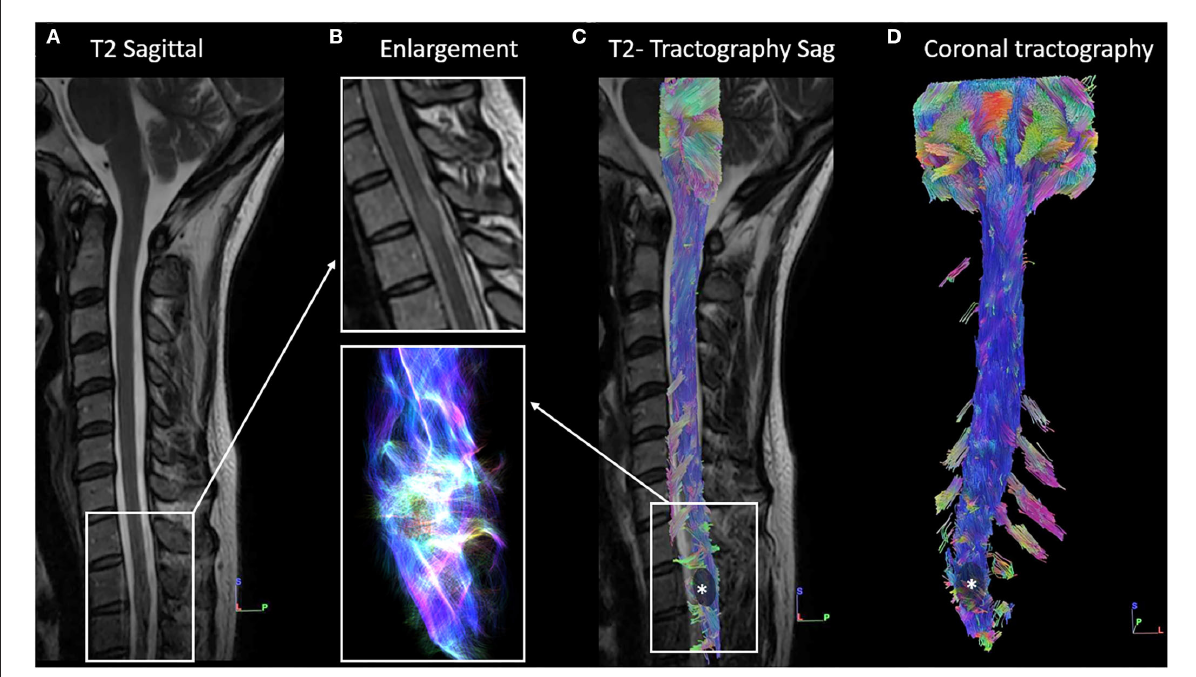
FIGURE6 Full cervical cord tractography in a patient with intramedullary tumor. (A) Sagittal T2-weighed image showing intramedullary isosignal at the Th2-Th3 spine level, associated with an increase in the volume of the spinal cord. (B) 1-Enlargement of the (A) at the level of intramedullary lesion, on the T2-weighed image. 2- Enlargement of the (C) on fiber tracking, according to a “line” style rendering performed in DSI Studio, at the level of the lesion. It shows warped fibers within the tumor, without safe access for spinal cord surgery. (C) Overlay of the spinal cord tractography on the sagittal T2-weighted image confirmed fiber deformation at the Th2-Th3 level. (D) Ventral view of spinal cord tractography showing warped fibers at the level of the tumor (in black with